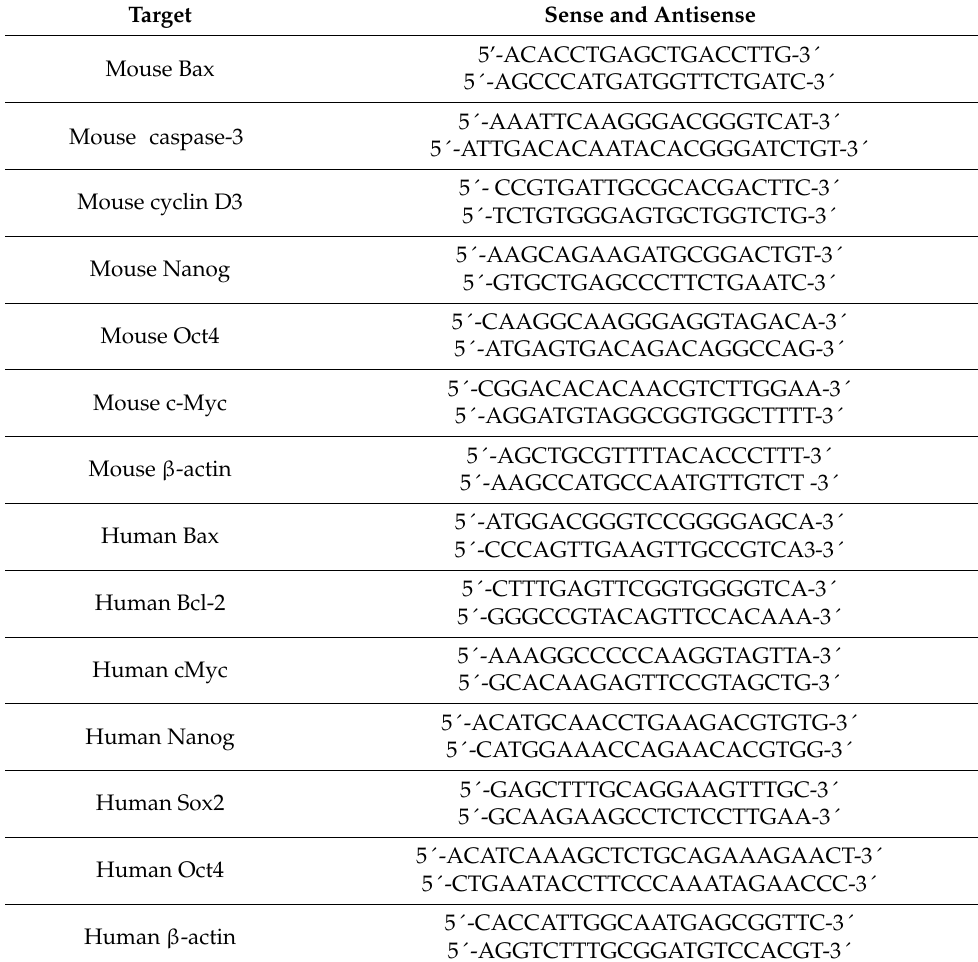
Table 1. Primers used for real-time